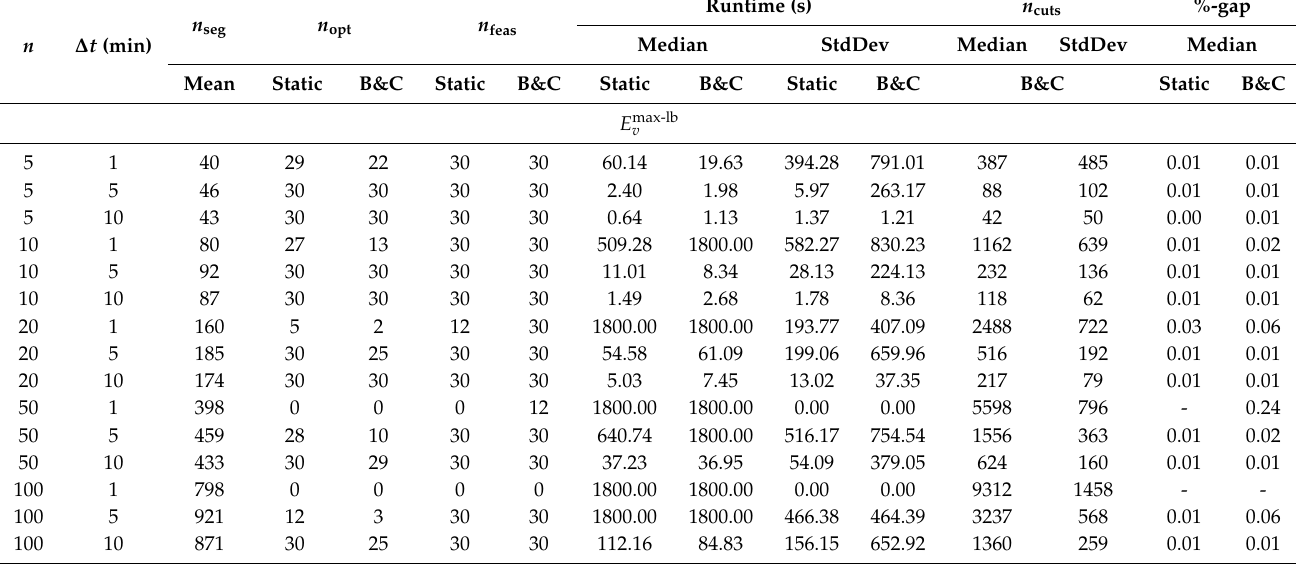
Table A4. EVS-SOC-GLIN results for solving the static model versus B&C with E max-lb v based on five-segment piecewise linear approximations of the original P max v functions, P gridmax = 25 n